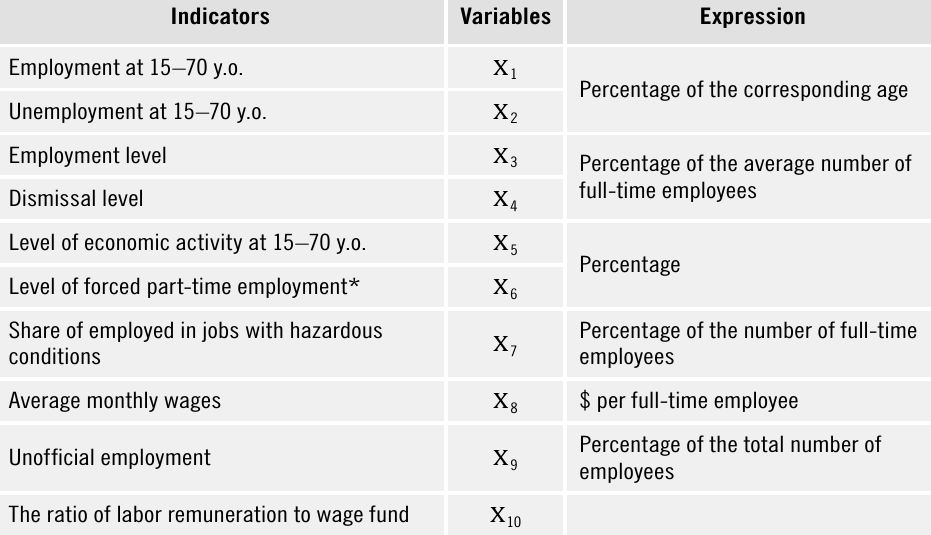
Table 2. Decomposition of attractiveness of regional labor markets Indicators Variables Expression Employment at 15–70